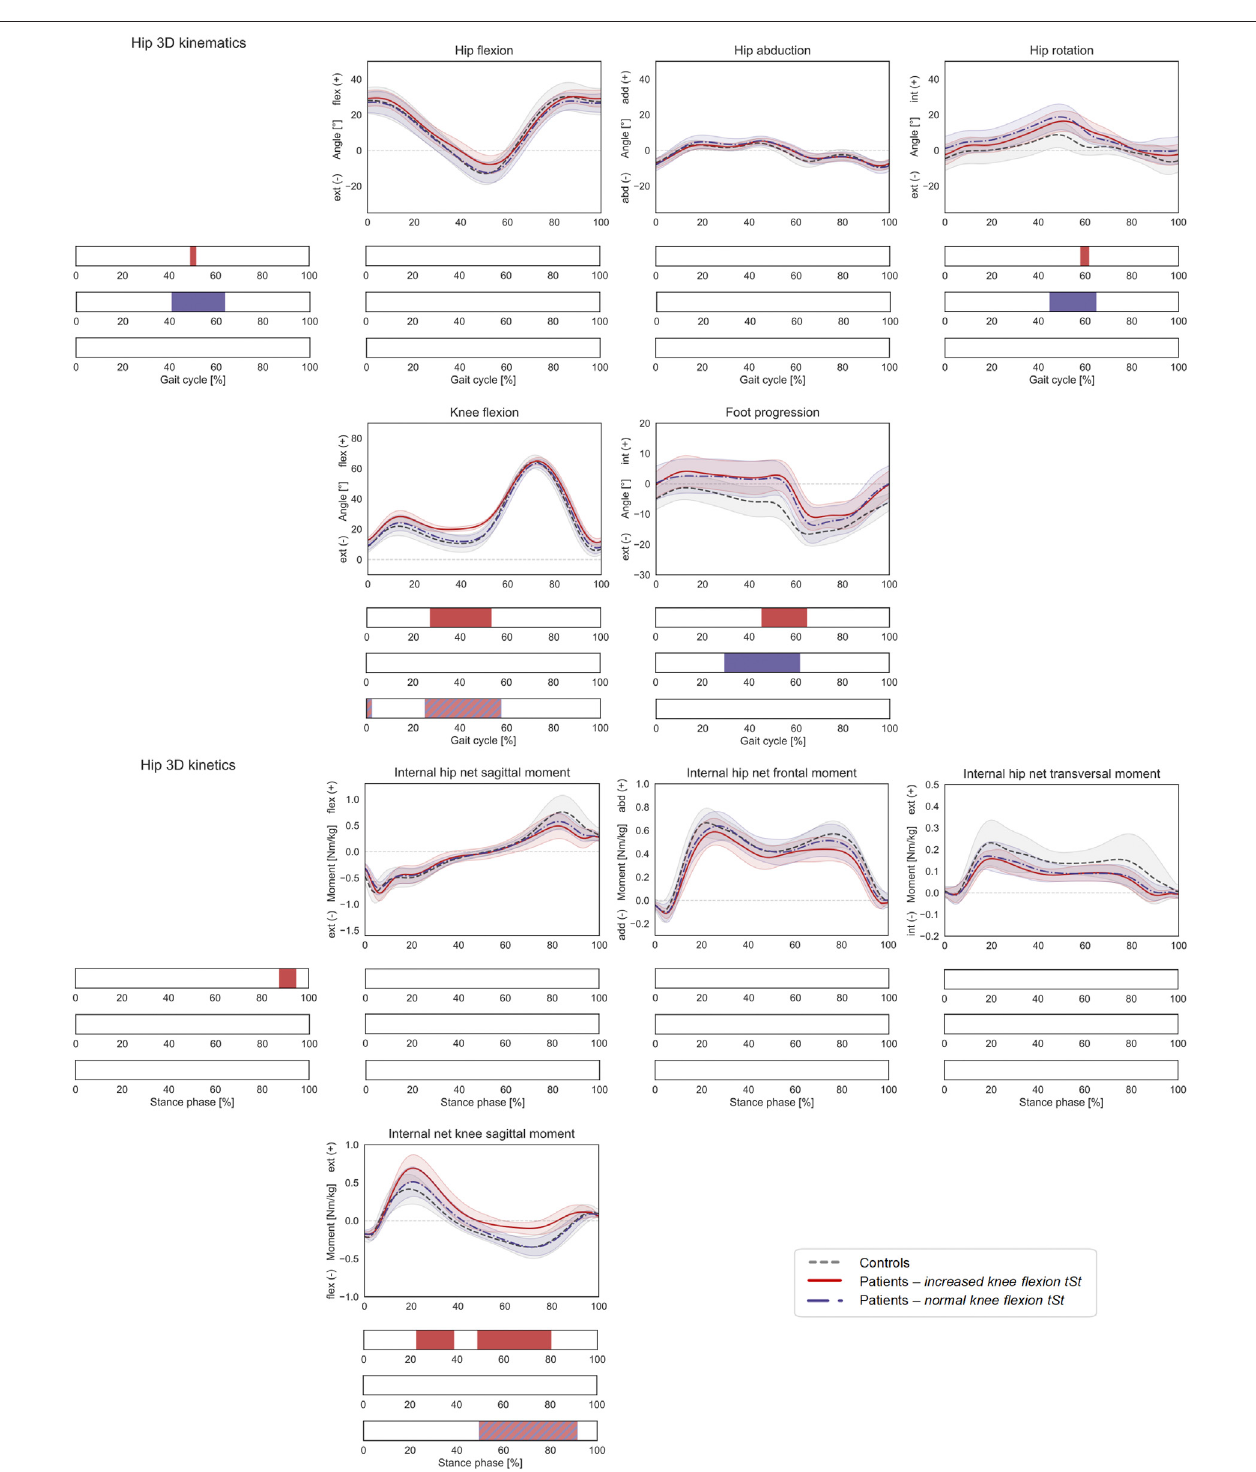
FIGURE6| Lower-limb kinematics during the gaitcycle(GC) andjointmoments during stance phase (ST)withpatient strati fi cation according toknee fl exionangle during terminal stance (KneeFlex tSt ). Mean ± 1SD hip fl exion, hip abduction, hip rotation, knee fl exion, and foot progression angles, as well as hip sagittal, frontal, transversal, and knee sagittal moments, are reported as grey dashed lines for controls, as red solid lines for patients with increased KneeFlex tSt , and as blue dashed- dotted lines for patients with normal KneeFlex tSt . Intervals ofGCor ST with astatistically signi fi cant differencein the relevant SPM tests are reported as red bars for the comparison between controls and patients with increased KneeFlex tSt , as blue bars for the comparison between controls and patients with normal KneeFlex tSt , and